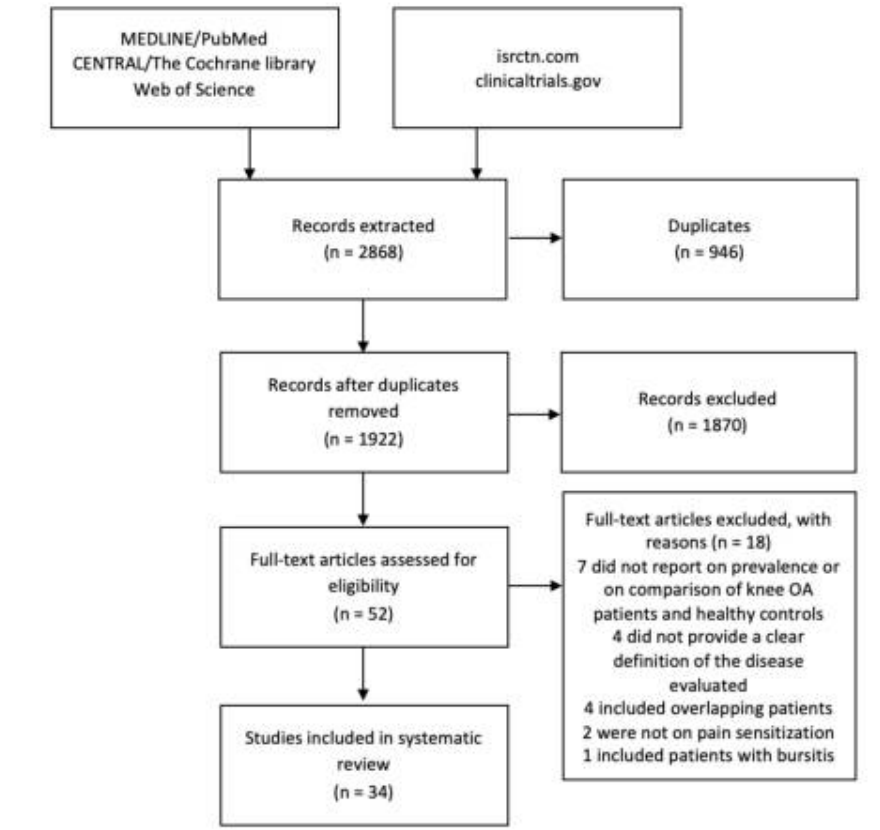
Figure 1. PRISMA flowchart of the study selection process. A total of 1831 patients were included: 406 with lateral epicondylalgia, 338 with Achilles tendinopathy, 290 with great trochanter pain syndrome, 287 with plantar heel pain, 211 with rotator cuff tears, 188 with patellar tendinopathy, 87 with shoulder impingement syndrome, 9 with ilio-tibial band syndrome, and 4 with quadriceps tendinopathy. In the reported studies the mean age ranged from 21.9 to 65.7, the mean BMI ranged from 22.2 to 33.7, and the mean pain duration ranged from 3 months to 10.6 years. Details on the characteristics of the included studies and patients are reported in Table 1.